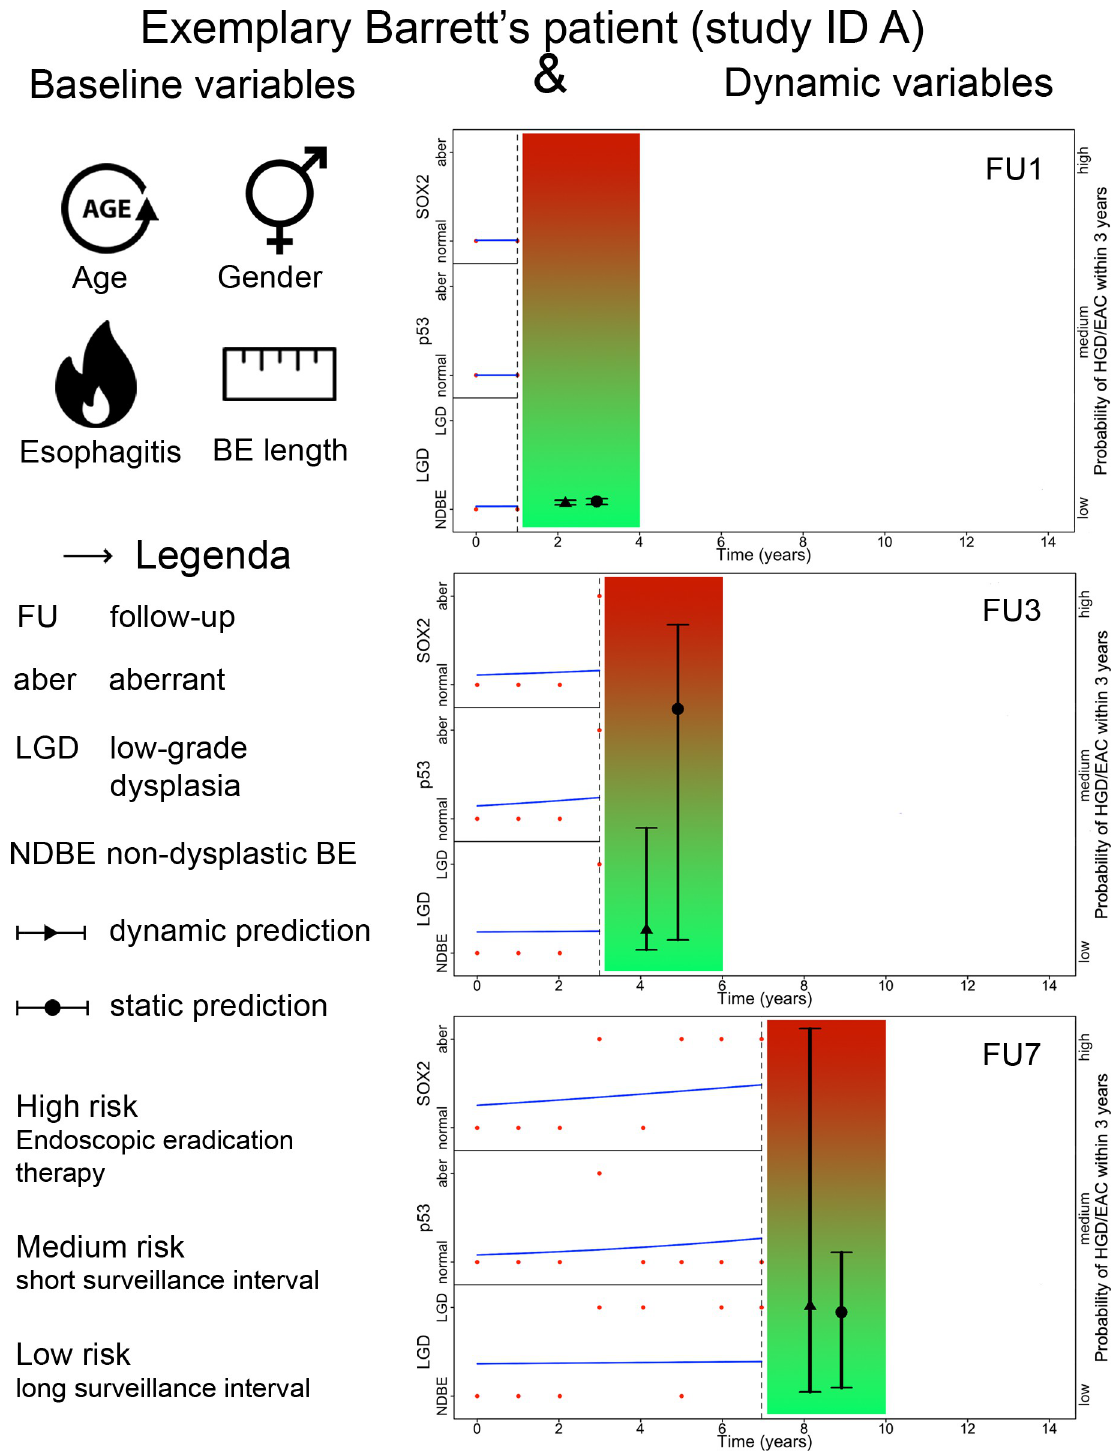
Fig 2. Neoplastic progression risk estimation of an exemplary BE patient (black bars, 95% CI) within three years at different FU moments (1, 3, 7), based on: 1) baseline variables (gender, age, esophagitis, BE length); 2) dynamic variables (red points represent measurements of three biomarkers, blue lines represent the probability of aberrant measurements in time). The difference between HGD/EAC risk estimations based on the dynamic and static model are displayed. In the static model the risk is only based on the last measurement. However, for the dynamic model the risk can be adjusted to all measurements; if there are more normal biomarker